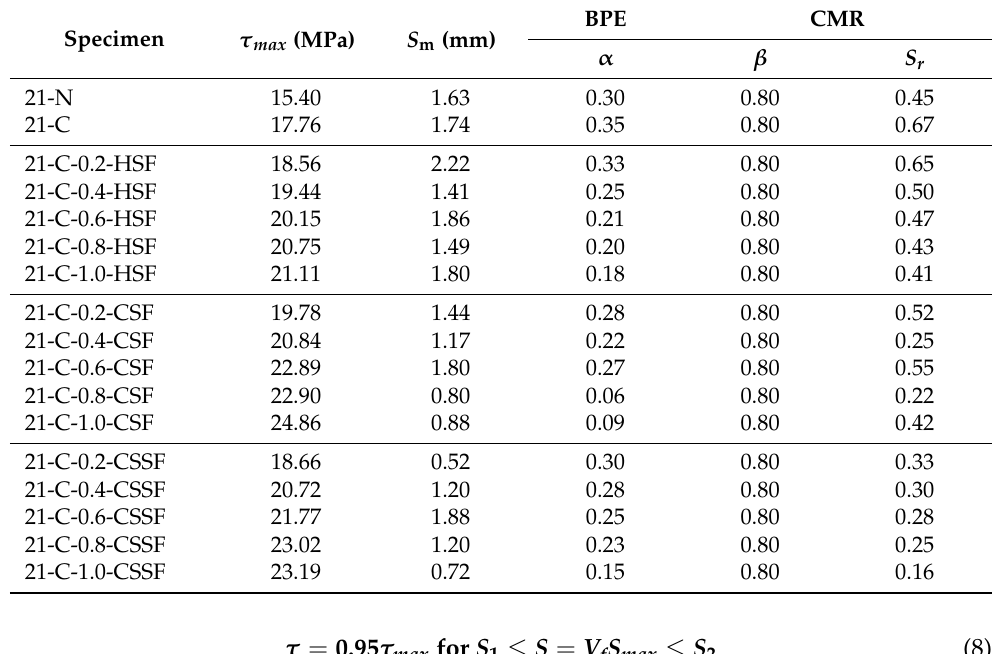
Table 6. Parameters for the ascending parts of existing models.